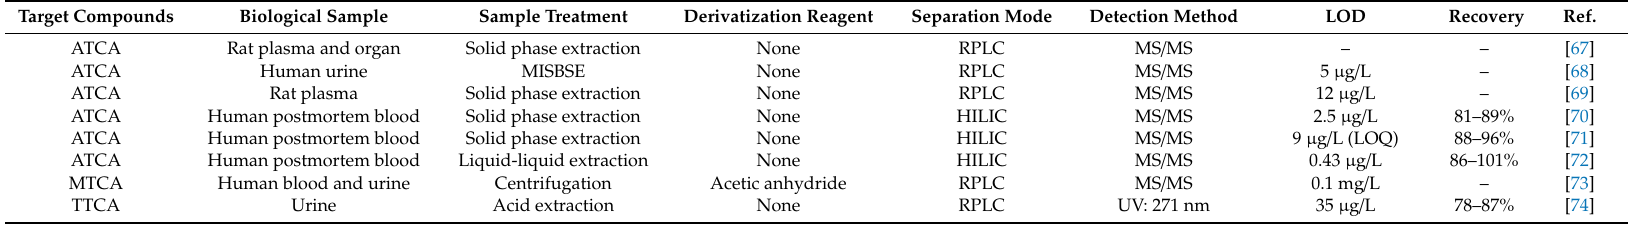
Table 6. Analytical methods for 2-aminothiazoline-4-carboxylic acid (ATCA), 2-methylthiazolidine-4-carboxylic acid (MTCA), and 2-thiothiazolidine-4-carboxylic acid (TTCA) in biological